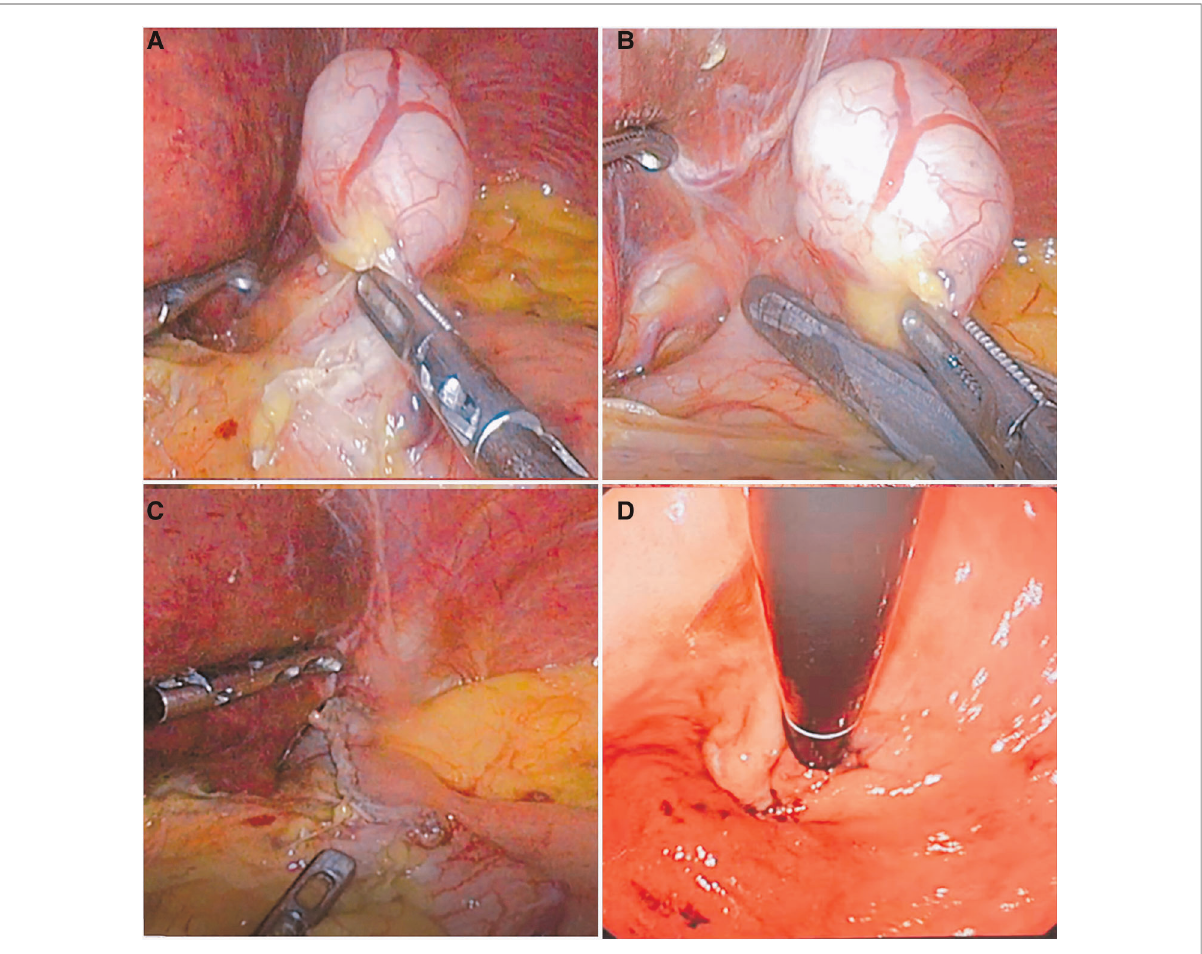
FIGURE 2 The fl ow chart of wedge resection. ( A ) The fat and blood vessels on the surface of the stomach in the cardia were opened, exposing the tumor site. ( B ) The tumor was pulled, and a linear stapler was made along the edge of the tumor to remove the tumor. ( C ) The tumor was completely resected. ( D ) Intraoperative gastroscopy was performed to check the patency of the